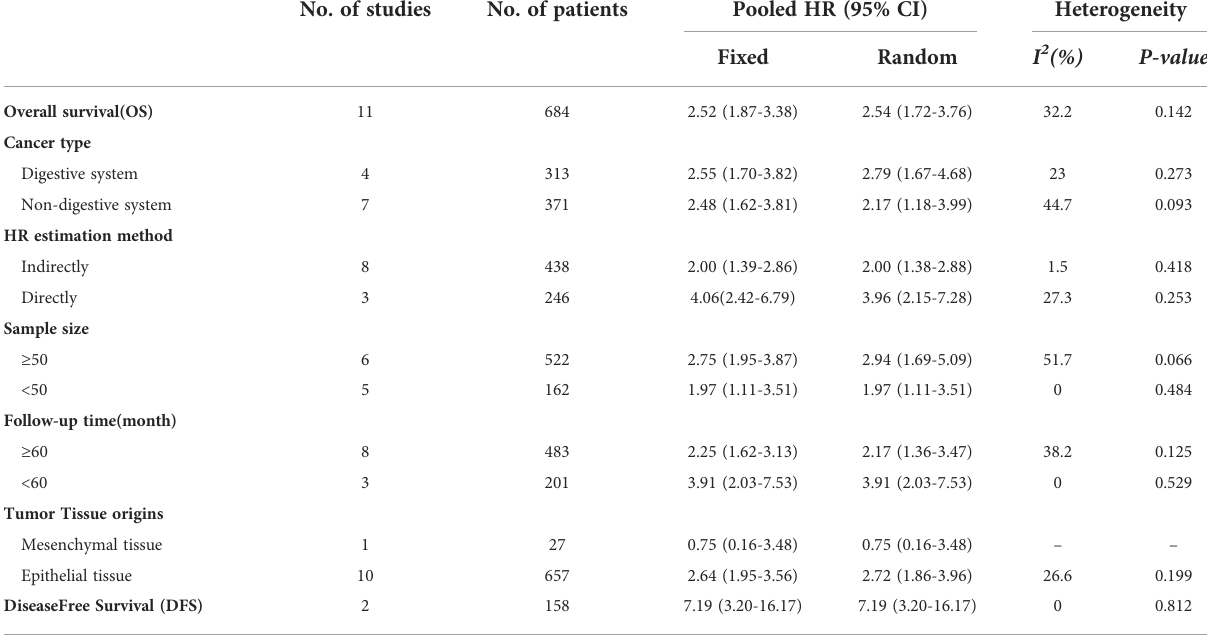
TABLE 2 Subgroup analysis of the pooled HRs with HOXA-AS2 expression in patients with malignancy. No. of